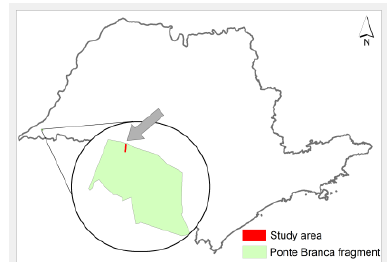
Figure 1. Study area located in the northwest part of São Paulo State, Brazil, belonging to the Ponte Branca forest